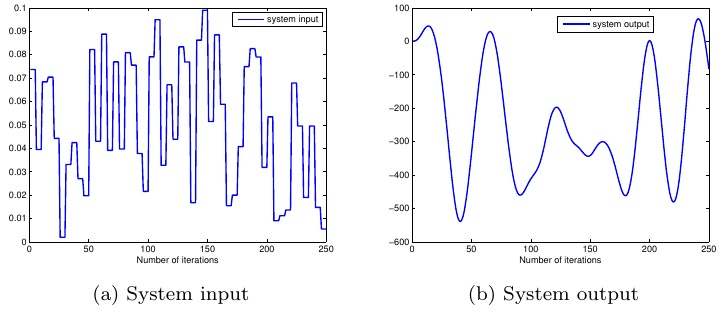
Figure 2. System